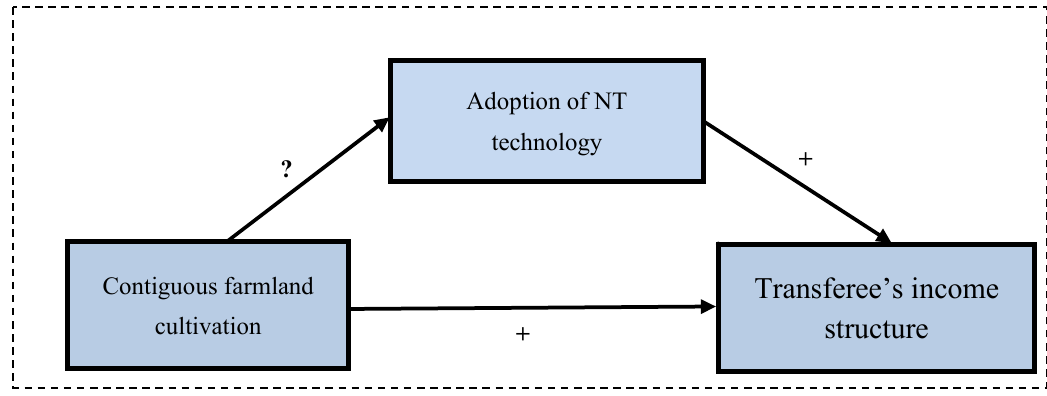
Figure 1. Theoretical framework used in the current study.